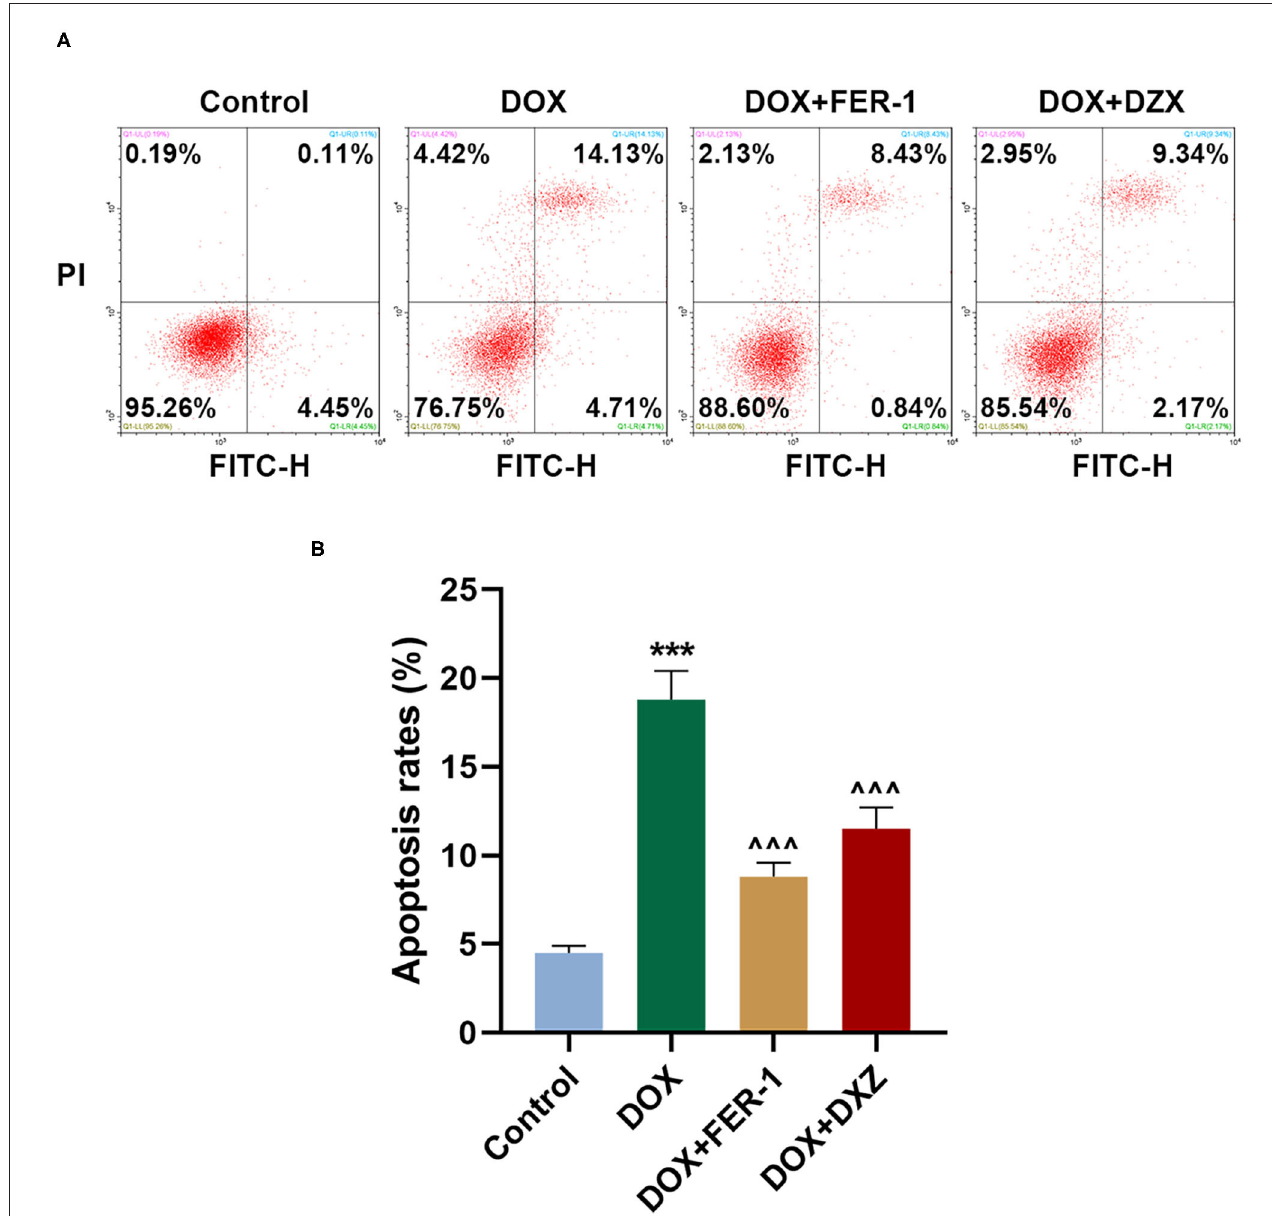
FIGURE 8 | Effects of HMGB1 and DXZ on DOX-induced apoptosis of H9c2 rat cardiomyocytes. (A,B) The apoptosis rate of H9c2 cells after drug treatment was detected by flow cytometry. Left upper quadrant represents dead cells, left lower quadrant represents live cells, right upper quadrant represents late apoptotic cells, and right lower quadrant represents early apoptotic cells. The apoptotic populations of cells were calculated according to right upper and lower quadrant. *** P < 0.001 vs. control. ∧∧∧ P < 0.001 vs. DOX. All experiments were repeated three